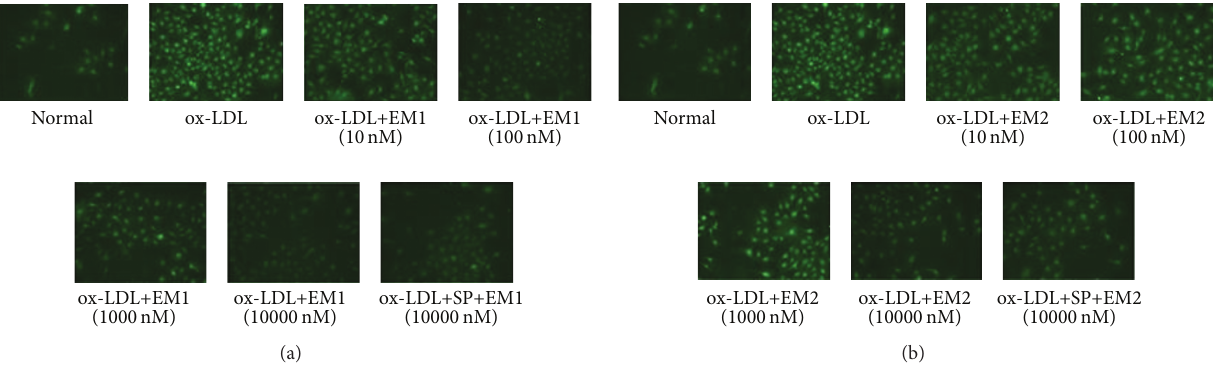
Figure8:(a)EffectsofEM1onp-JNKproteininHUVECsinducedbyox-LDLfor48hbyfluorescencemicroscopewitha × 200magnification. (b) Effects of EM2 on p-JNK protein in HUVECs induced by ox-LDL for 48 h by fluorescence microscope with a × 200